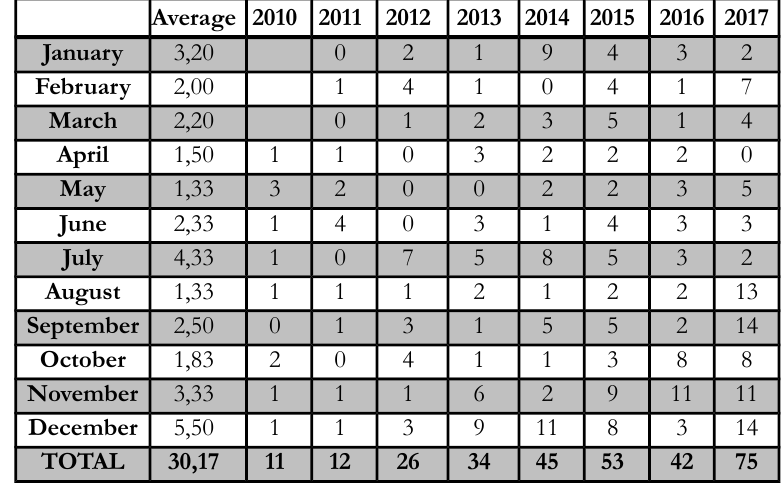
Table 1. Article submissions evolution from 2010 to 2017